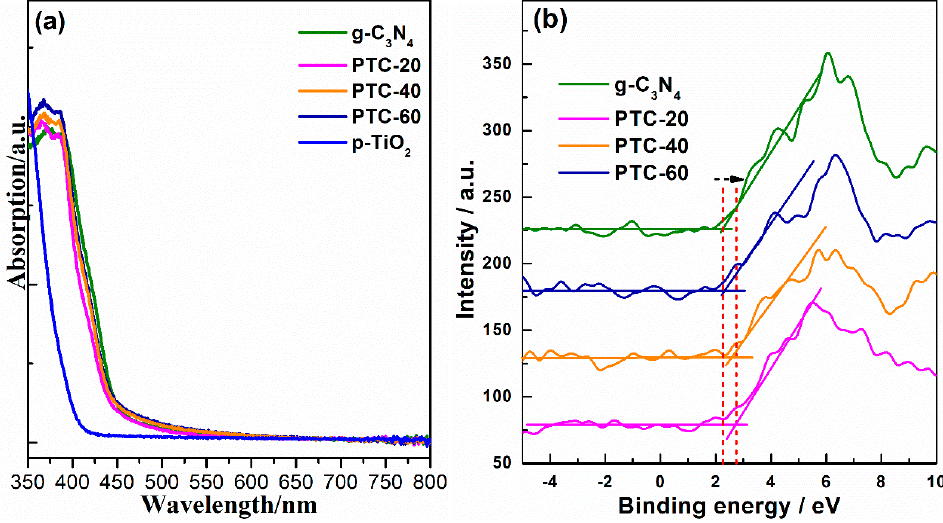
Figure 7. ( a ) UV-vis DRS spectra and ( b ) valence band density of states (DOS) of layered g-C 3 N 4 , PTC-20, PTC-40 and PTC-60.